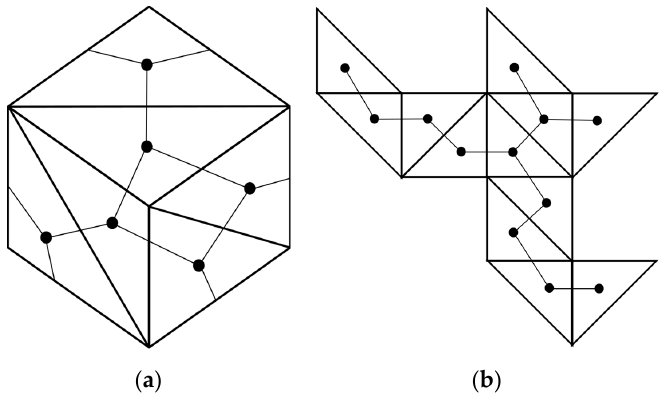
Figure 18. ( a ) Each face of a cube is divided into two equilateral triangles to convert the six faces into ( b ) twelve triangular faces. Once a cube is cut along the edges of the triangles to produce a Dürer net, a spanning tree connects the centroid of each triangle (shown as a black dot on each face), according to their adjacency on the surface of the original cube.